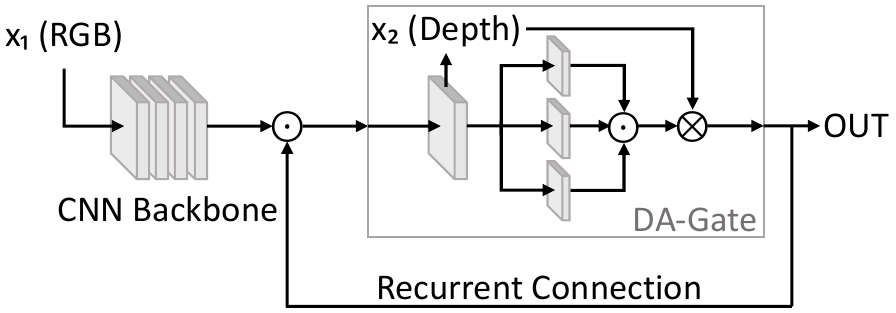
Figure 9. Fusion architecture proposed in [103].